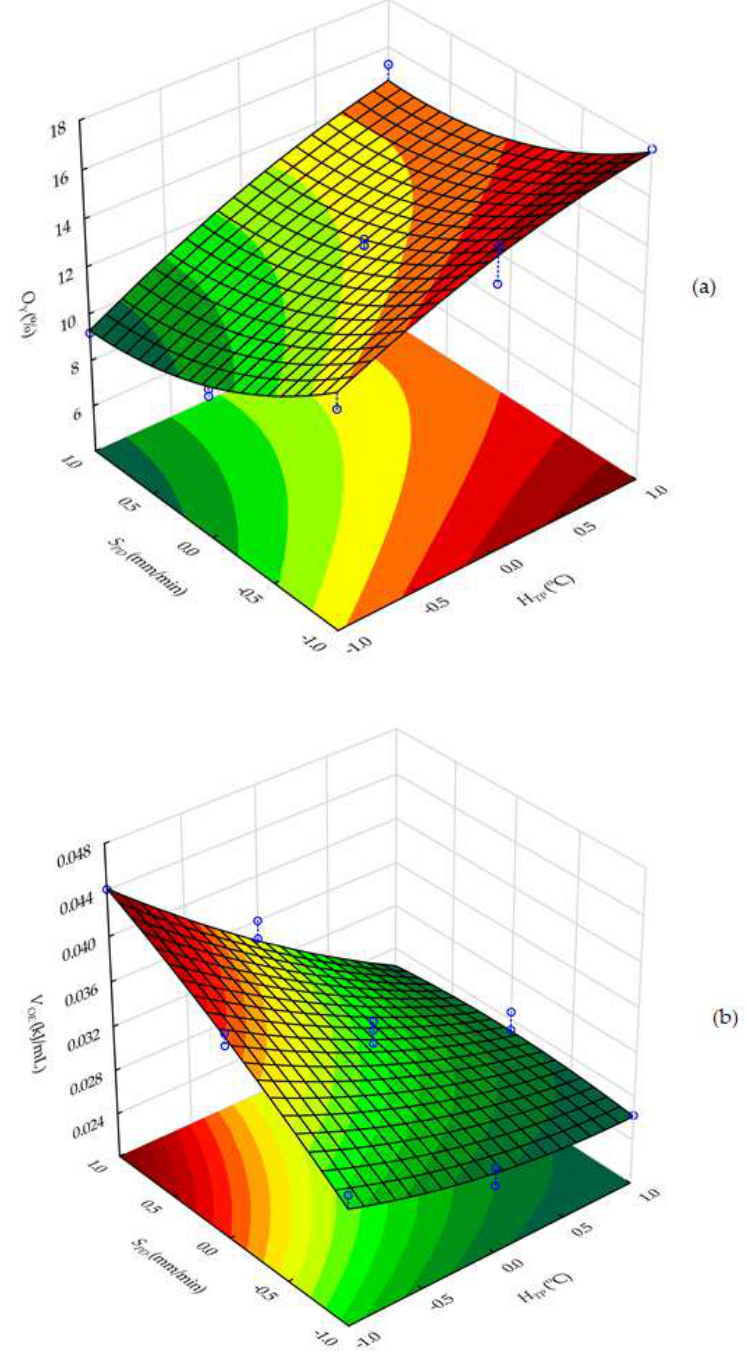
Figure 5. Fitted surface plots of ( a ) O Y , oil yield, and ( b ) V OE , the volume of oil energy grouped by H TP , heating temperature ( ◦ C) and S PD , speed (mm/min), representing the other factor